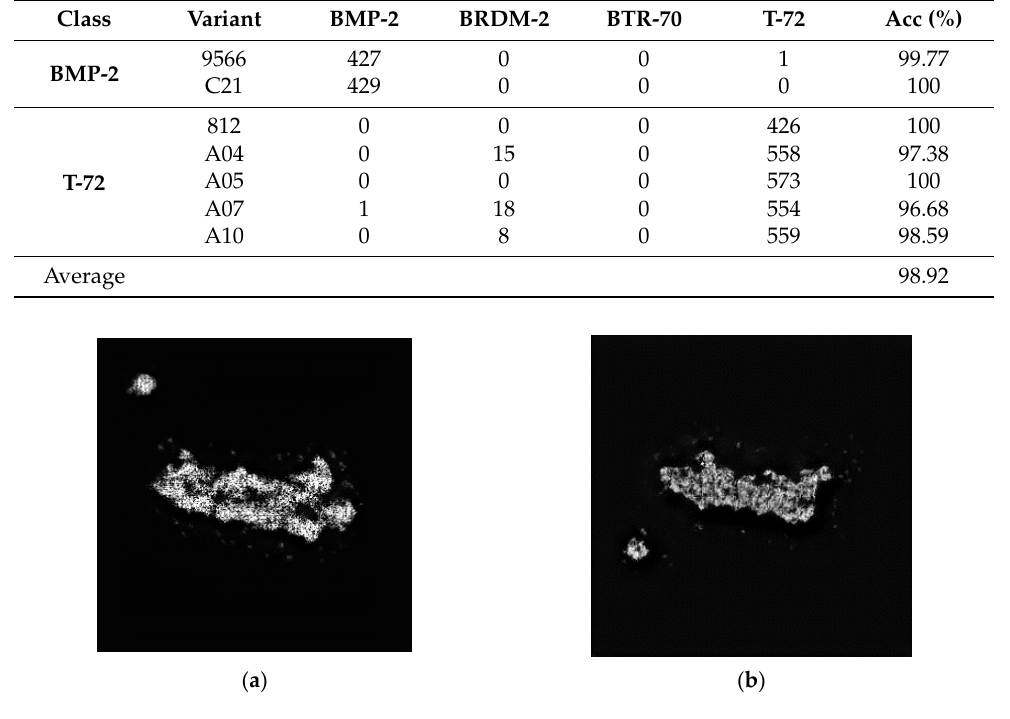
Figure 14. Images of ( a ) T-72/A07 and ( b ) BRDM-2. Table 9. The confusion matrix under EOC2 (version variant) based on the proposed method.